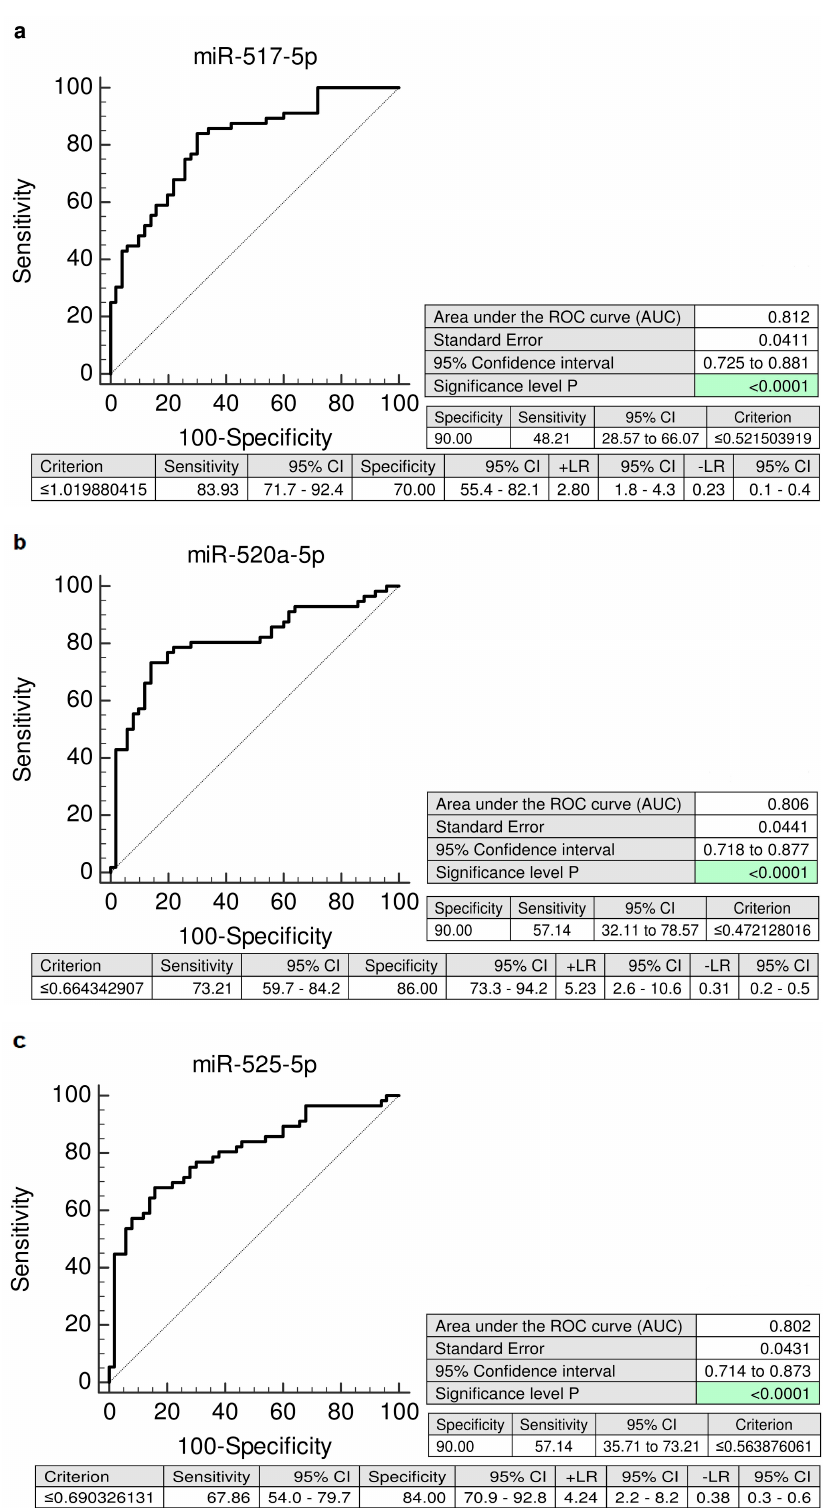
Figure 2. ROC curves—individual C19MC microRNA biomarkers—evaluation of the potential of the first trimester C19MC microRNA screening in plasma exosomes to predict later onset of GH. Decreased levels of miR-517-5p, miR-520a-5p, and miR-525-5p were detected in women destinated to develop GH when the comparison to the controls was performed both ( a – c ). GH: gestational hypertension.